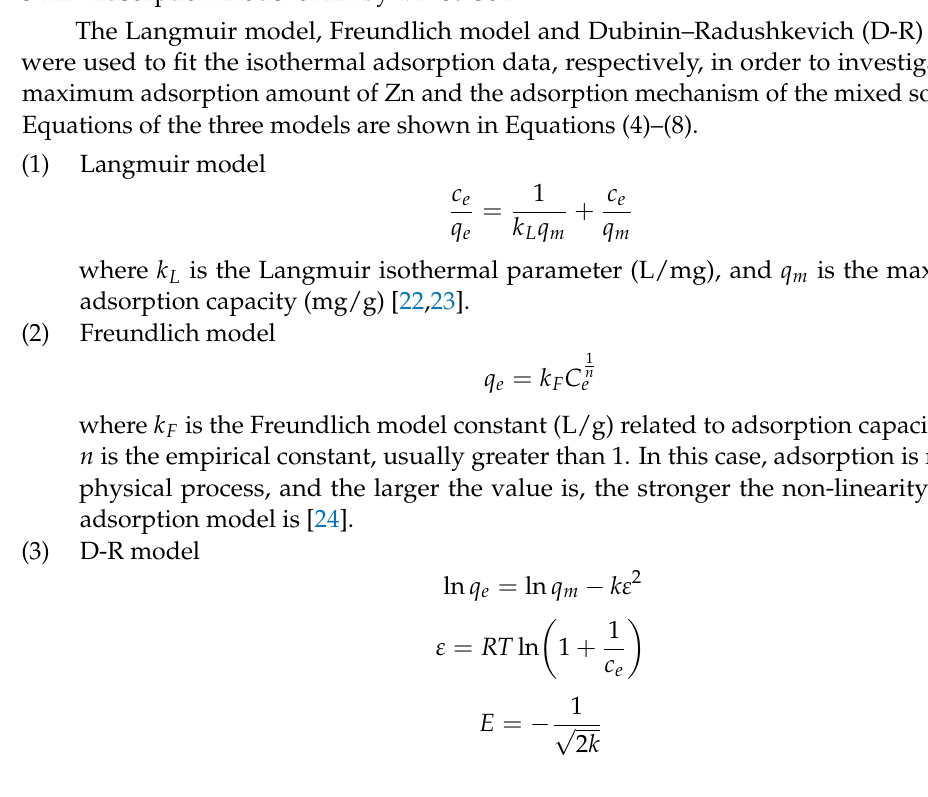
Figure 3. Relationship between initial concentration and adsorption concentration.